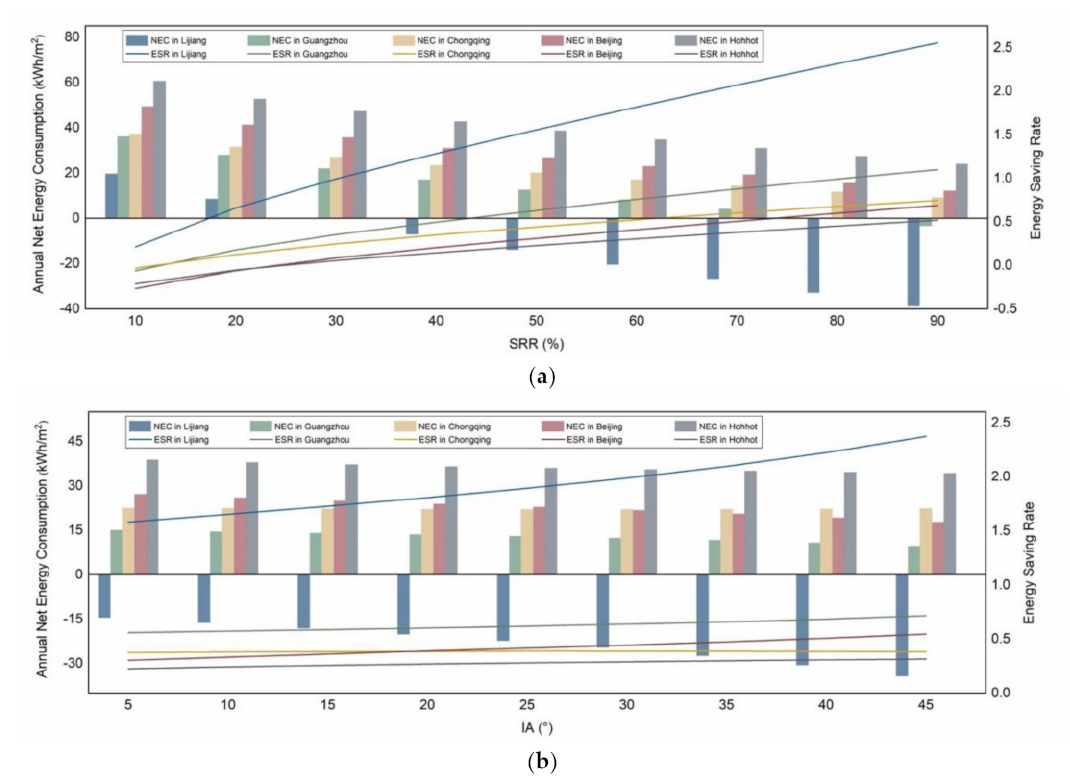
Figure 8. Energy savings rates of buildings integrated with STPV skylights: ( a ) flat roof; ( b ) sloped